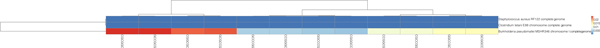
The CCCGGG-Spectrum set test. The sequence data is analyzed by base composition to determine relatedness.